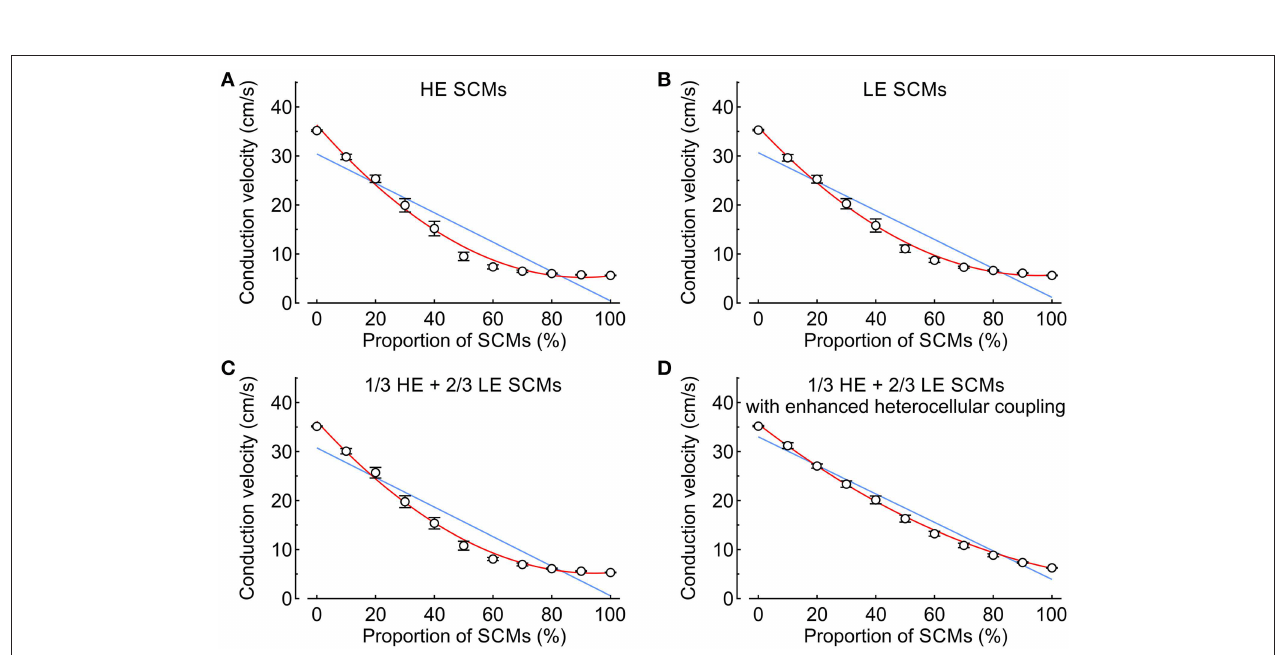
FIGURE 6 | Conduction velocity vs. proportion of SCMs (0–100% in steps of 10%) in simulated strands (mean ± SD; n = 20 for every data point). Blue lines and red curves represent linear and quadratic fits to the data, respectively (fitting parameters in Table 3 ). (A) Strands combining PCMs and SCMs with high excitability. (B) Strands combining PCMs and SCMs with low excitability. (C) Strands in which the SCMs were distributed with a ratio of 2:1 between low and high excitability SCMs. (D) Same as (C) , but with a fourfold increase of the heterocellular coupling conductance between SCMs and PCMs.